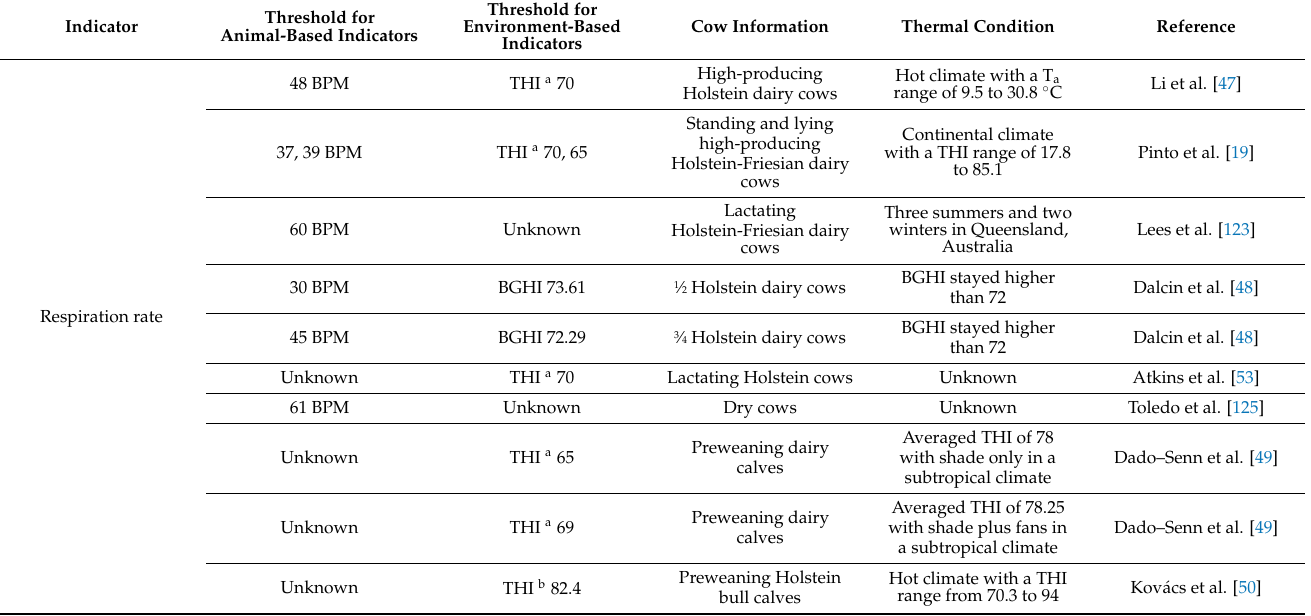
Table 4. Summary of the thresholds of respiration-related